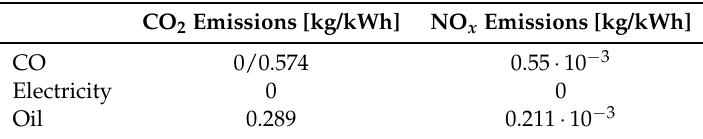
Table 2. Emission factors for CO 2 and NO x per kWh produced